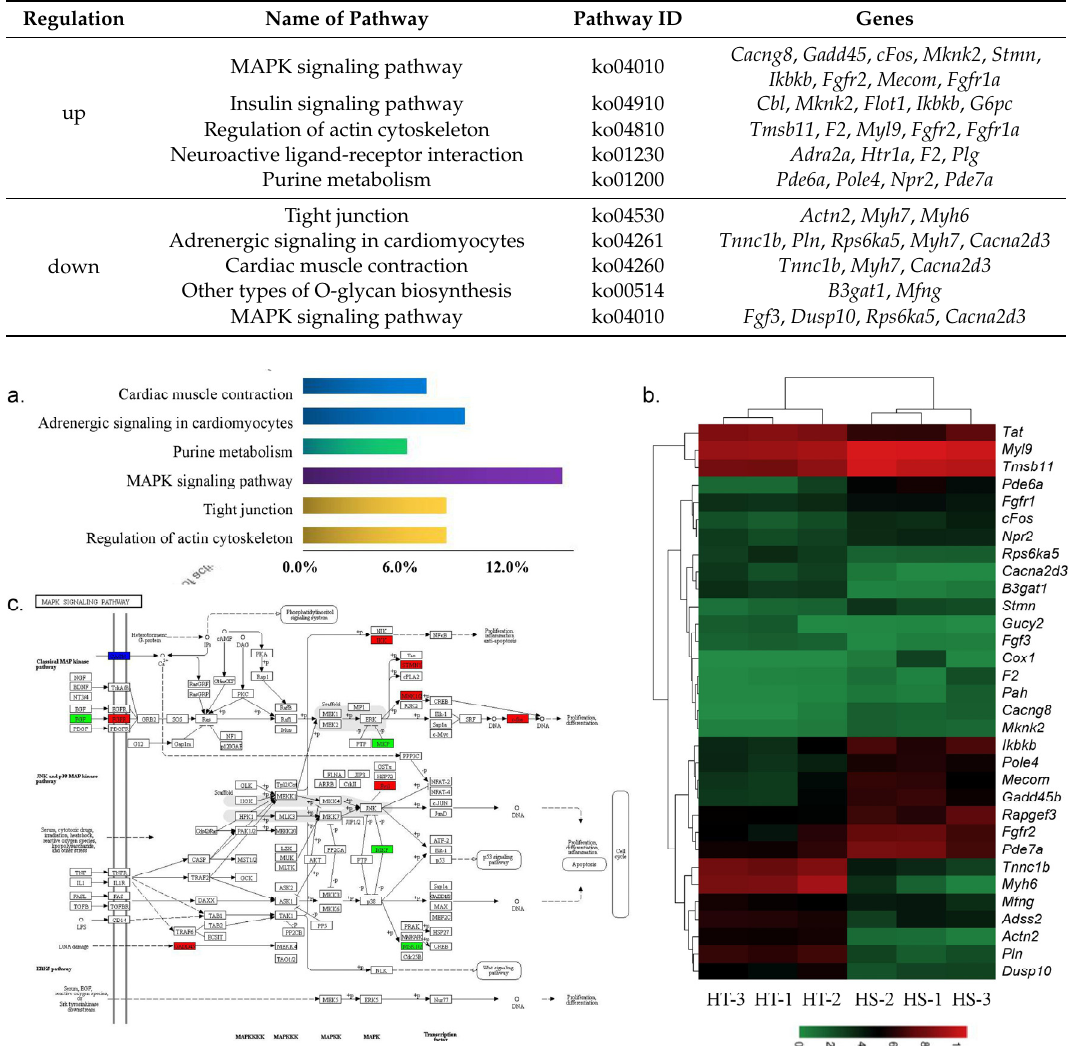
Table 2. Top KEGG pathways and DEGs in heart transcriptome between hypoxia-sensitive and tolerant bighead carp.